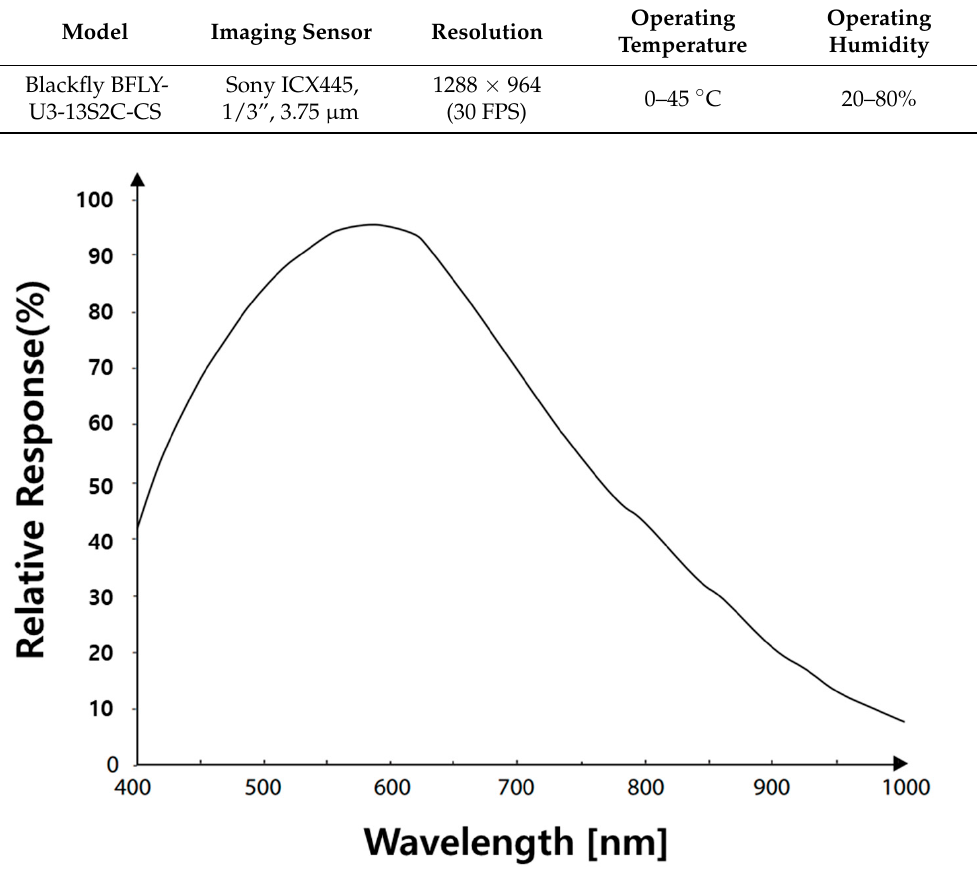
Figure 1. Spectral sensitivity of the imaging sensor, Sony ICX445.